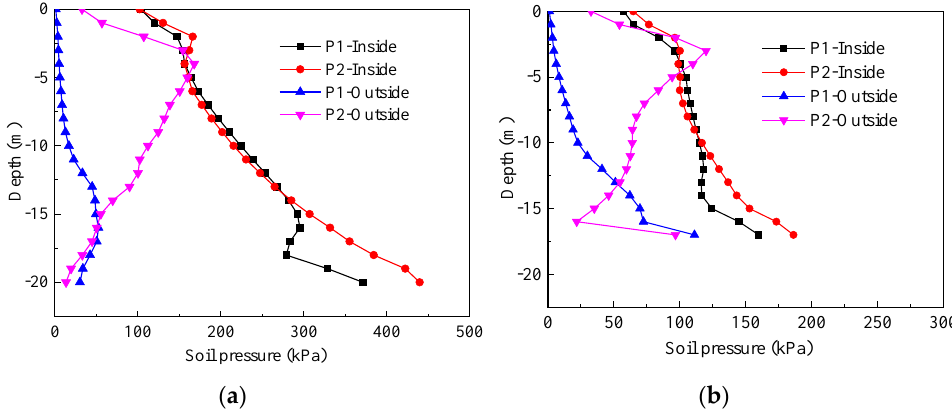
Figure 5. The inside and outside earth pressure of 1# of the TSPJF and TBJF. ( a ) TSPJF, ( b ) TBJF.